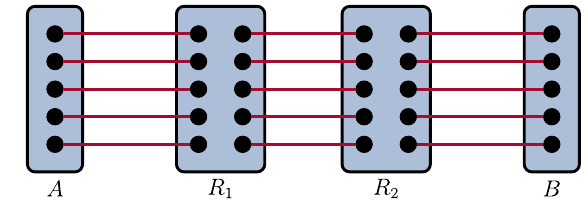
Fig. 11 A repeater chain with M = 3 elementary links. All of the elementary links have equal length, and there are N mem = 5 quantum memories per repeater